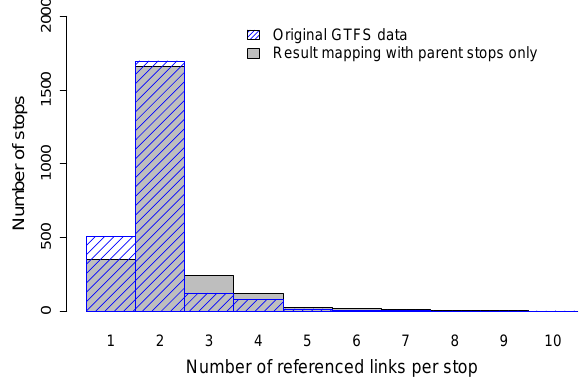
Figure 7. Histogram of the number of stop locations per parent stop; original data (blue) vs. algorithm generated data